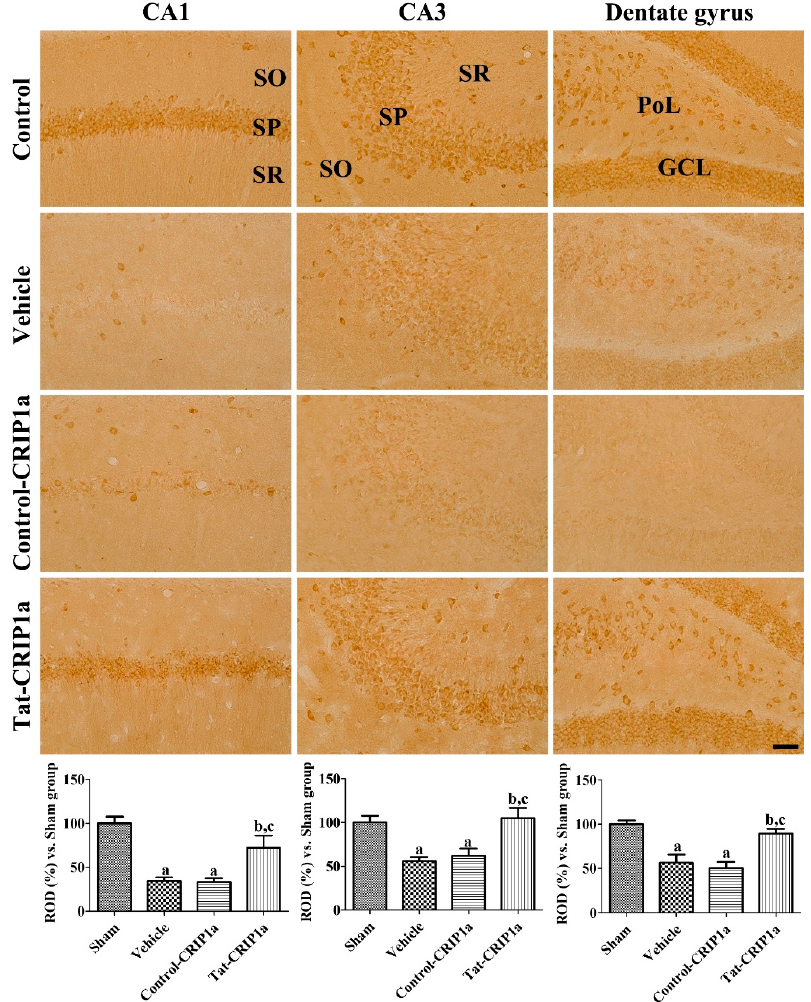
Figure 6. Immunohistochemistry for 14-3-3 η in the hippocampal sub-regions of the sham, vehicle, Control-CRIP1a, and Tat-CRIP1a groups at 4 days after ischemia. In the CA1 and CA3 regions, the